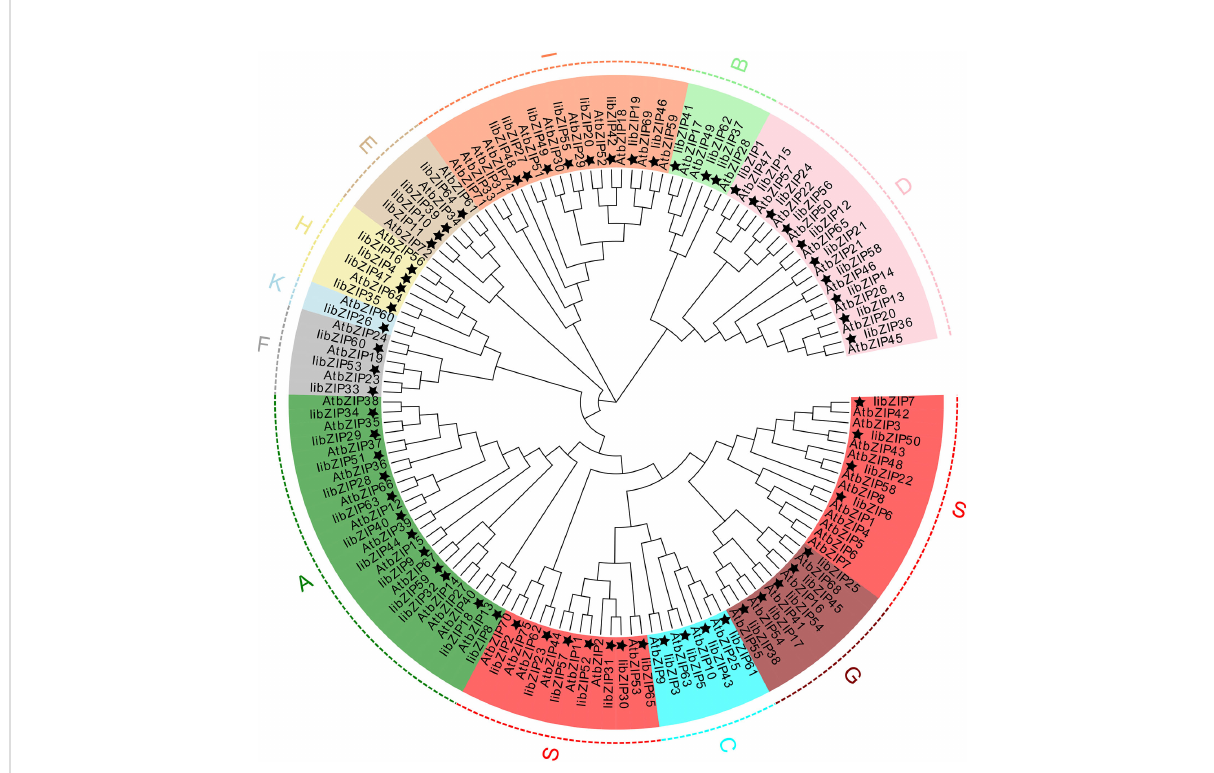
FIGURE 2 Phylogenetic tree for bZIP proteins of I. indigotica and A.thaliana thaliana. The topology was assessed with a bootstrap analysis with 1000 replicates. A star indicates the IibZIP proteins, and different colors and letters represent different